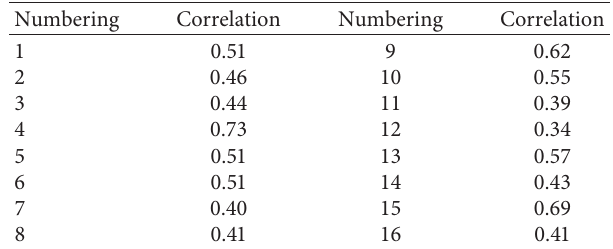
Figure 11: A1B1C4D4E4 combined simulation results with (a) warpage and (b) volume shrinkage. Table 9: Gray correlation results.